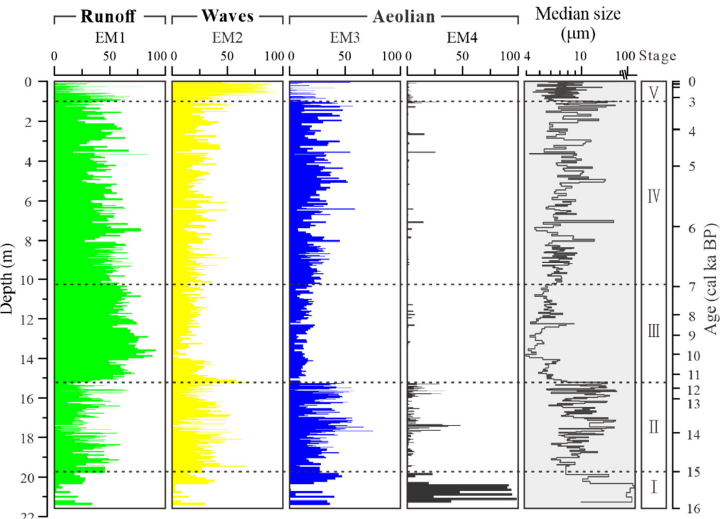
Figure 6. EM scores and median size of core AGL ‐ 2010.